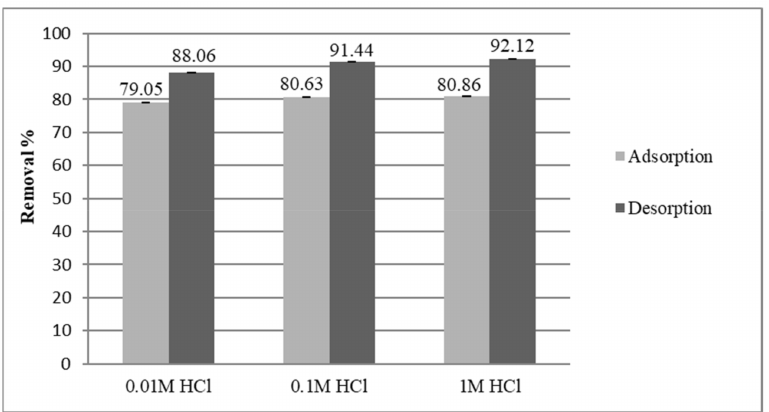
Figure 5. Adsorption and desorption of Cd with three concentrations of HCl—0.01 M, 0.1 M and 1